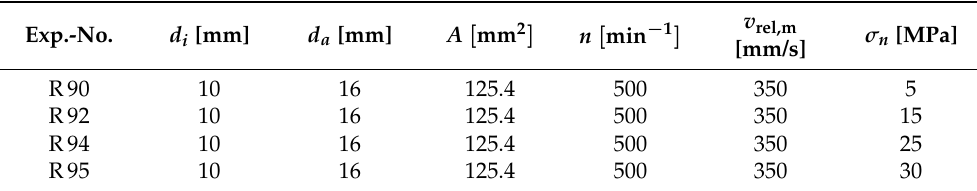
Table 2. Parameter sets of test series R90 to R95 carried out with Tool Number 1 (as shown in Figure